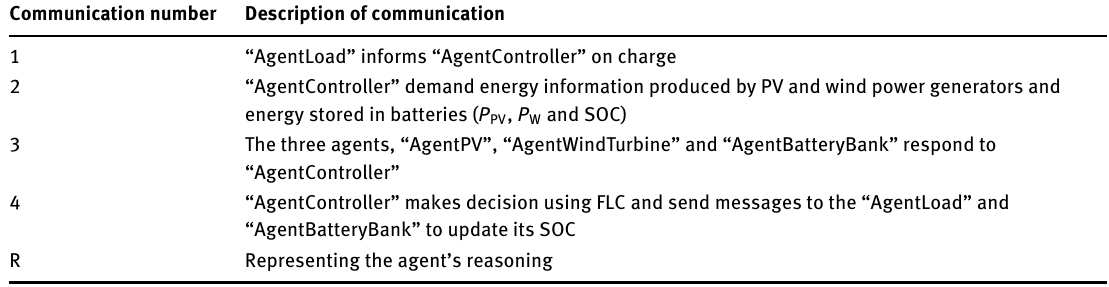
Table 1: Communications List for Energy Management. Communication number